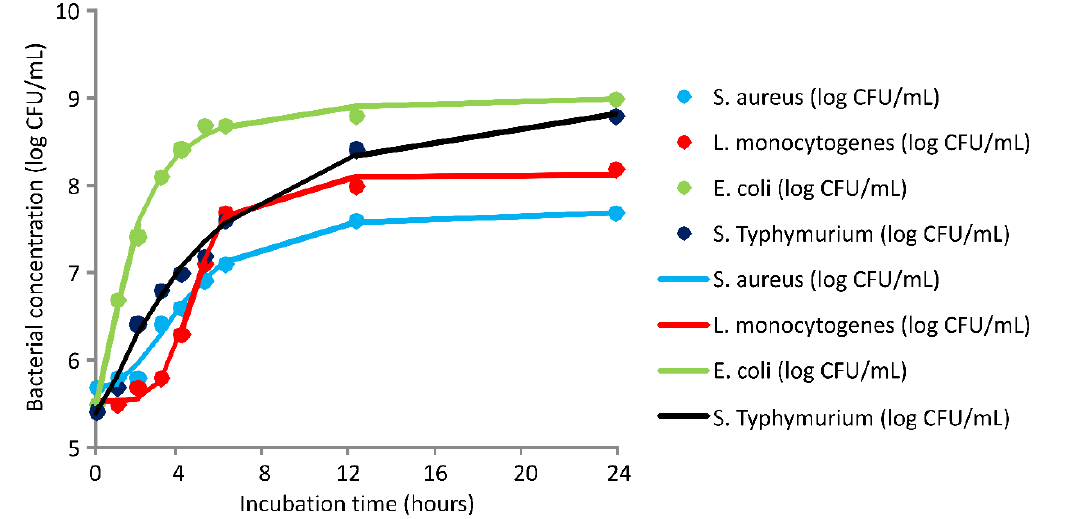
Figure 1. Bacterial growth kinetics—control samples (incubation of sensitive bacteria without the tested antimicrobial substances)—markers signify the experimental data; lines indicate predictive results.